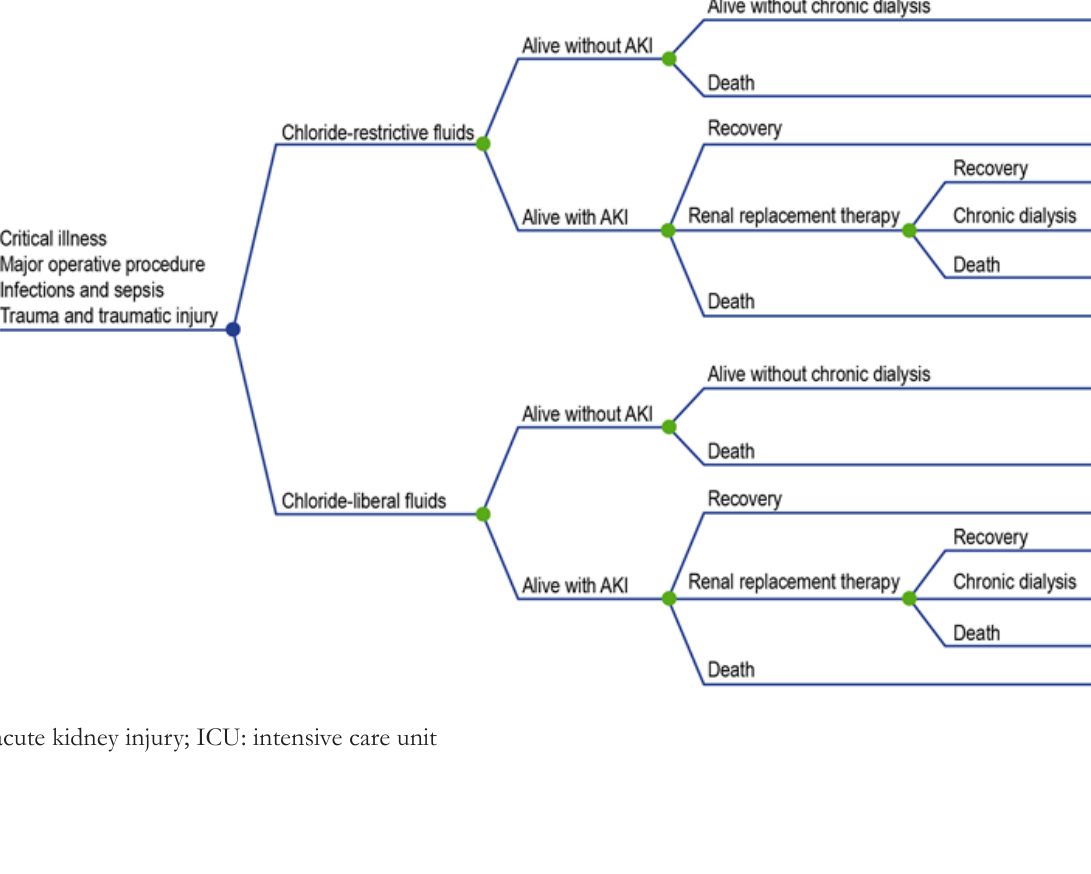
Figure 2. Markov Model Health States (Annual